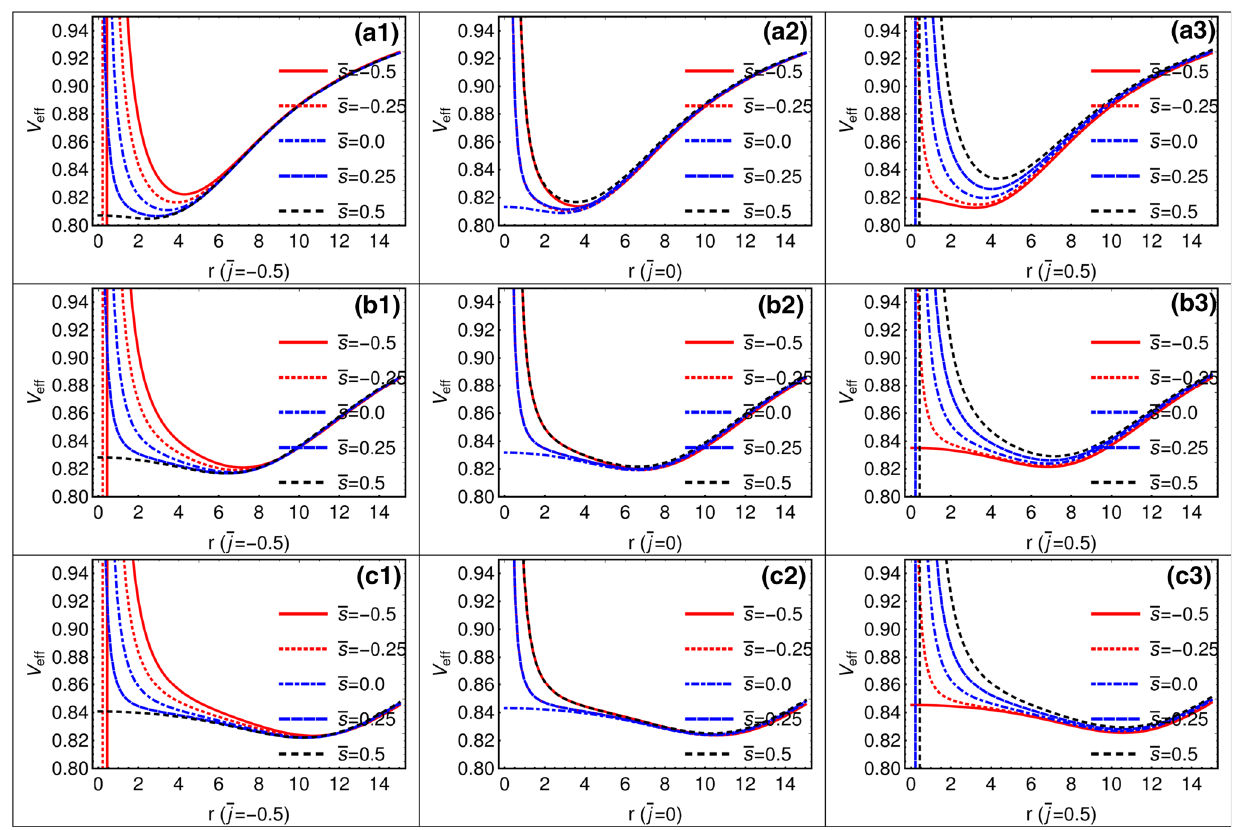
Fig. 1 Theeffectivepotentialsofthespinningtestparticlefordifferent values of the particle spin ¯ s , total angular momentum ¯ j , and angular number k . The angular number k is taken as k = ( 1 , 2 , 3 ) for